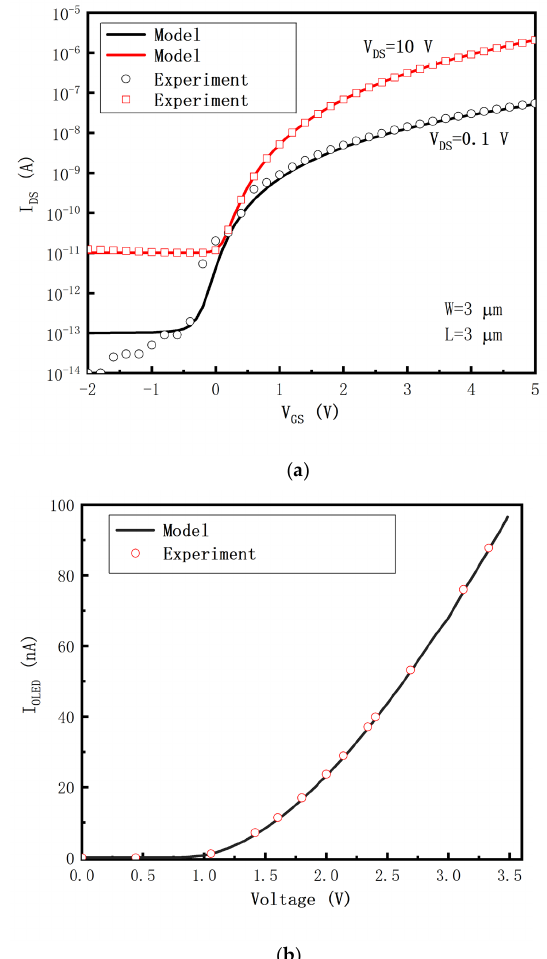
Figure 4. ( a ) The transfer characteristic of the a-IGZO TFT [8], and ( b ) the electrical characteristic of the OLED [33] .